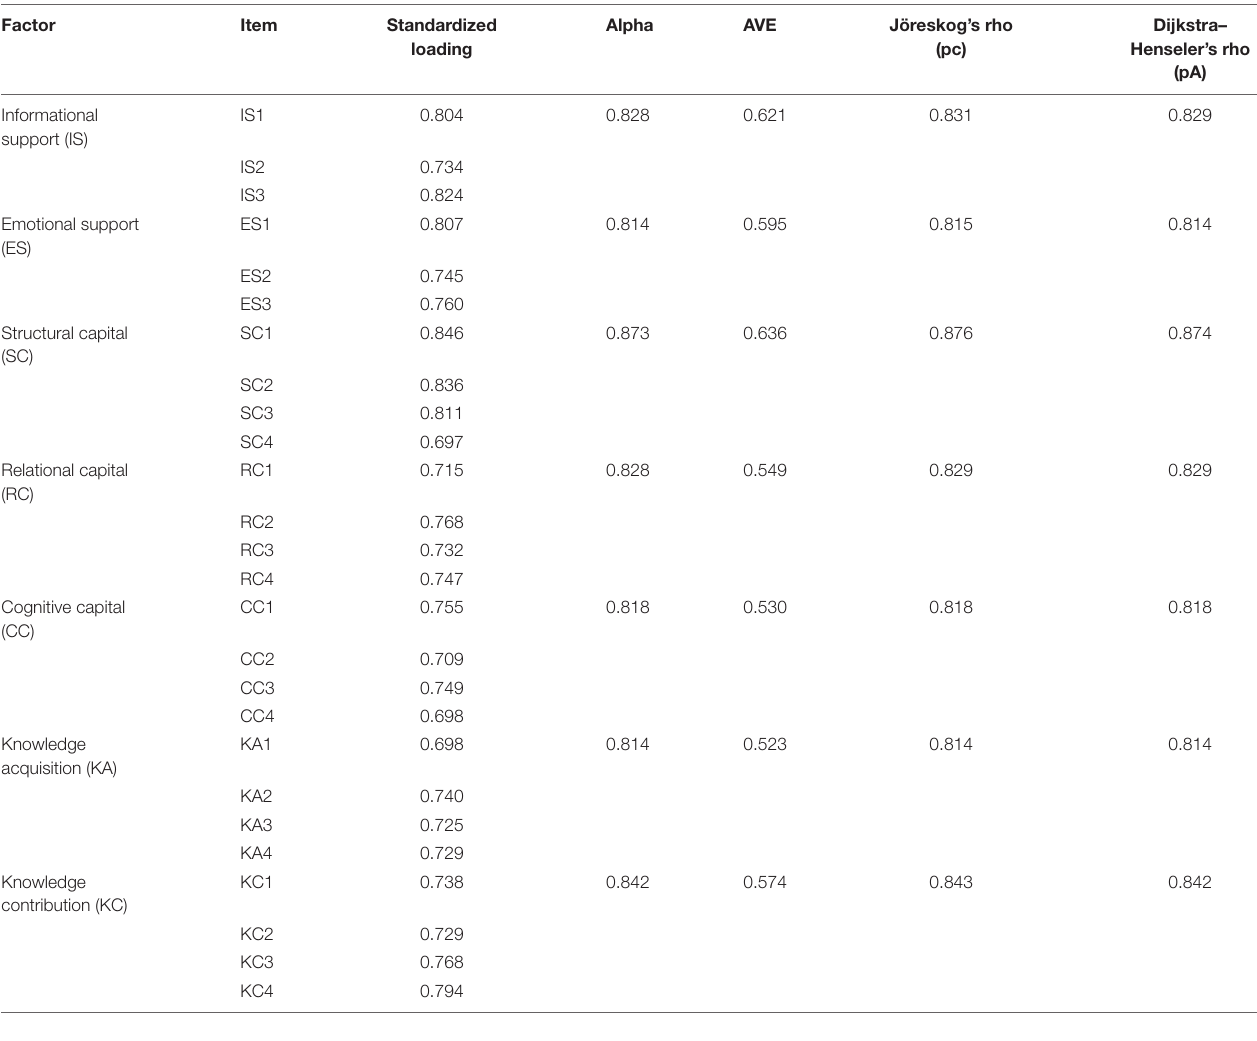
TABLE 2 | Standardized item loadings, AVE, alpha, and rho values.